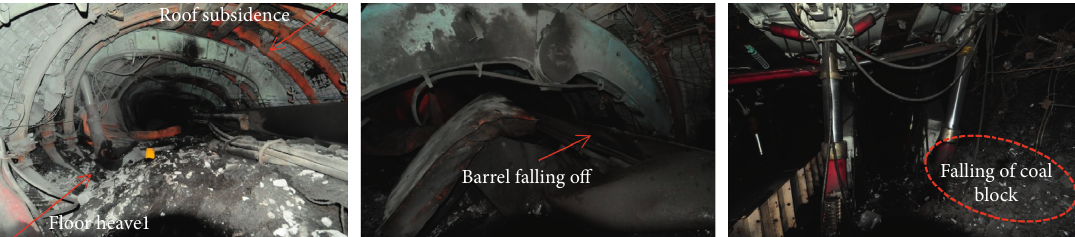
Figure 8: Scene photos of roadway rock burst accident in Yuejin